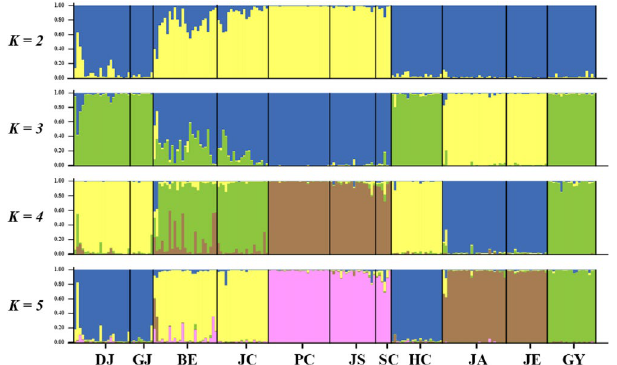
Figure 5. Bayesian genetic structure among Karsenia koreana populations estimated based on the microsatellite data using Structure. Since the program could not identify one optimal number of genetic clusters, four serial plots from K = 2 to 5 are presented. Population codes follow Table